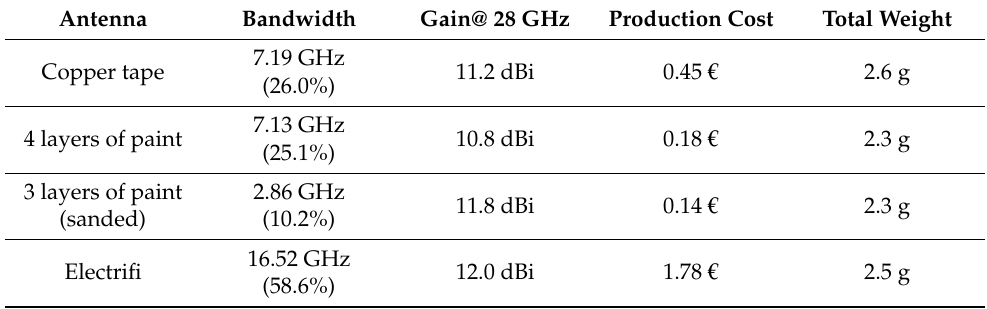
Table 6. Comparison of the different